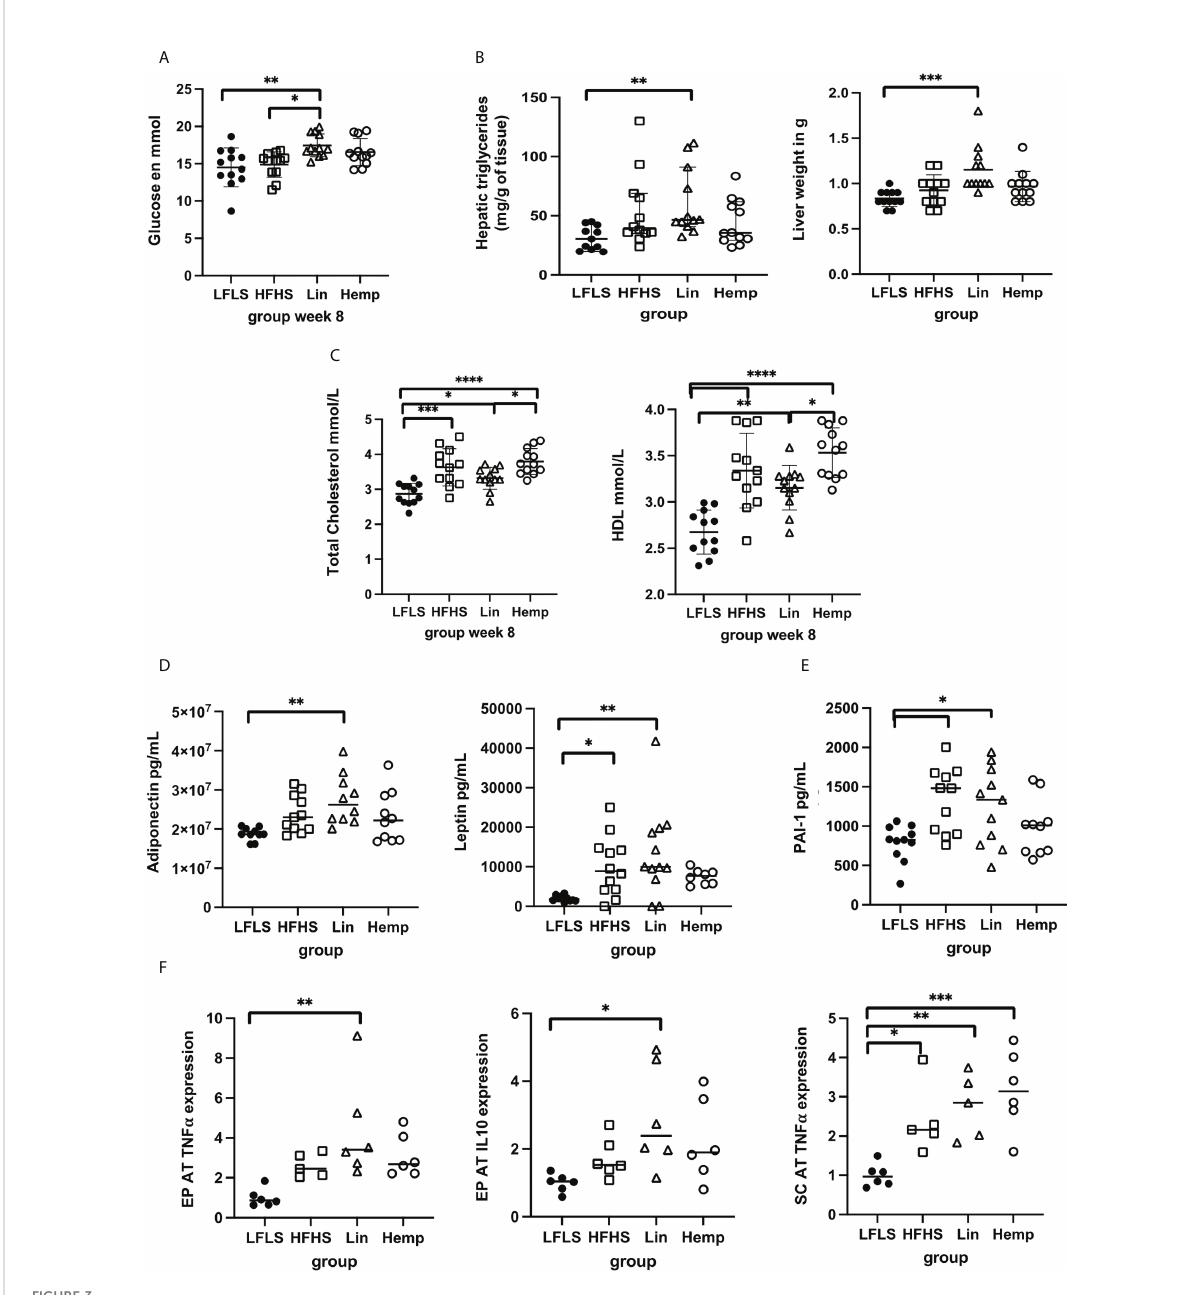
FIGURE 3 Assessment of metabolic parameters, cytokines, and adipokines after 8 weeks of HFHS diets. (A) Fasting glucose levels; (B) liver triglyceride content and weight; (C) total cholesterol and HDL levels; (D) circulating levels of adipokines; (E) circulating levels of PAI-1; (F) epididymal (EPAT) and sub-cutaneous (SCAT) levels of TNF- a and IL-10. * p < 0.05; ** p < 0.01; *** p < 0.001; **** p <